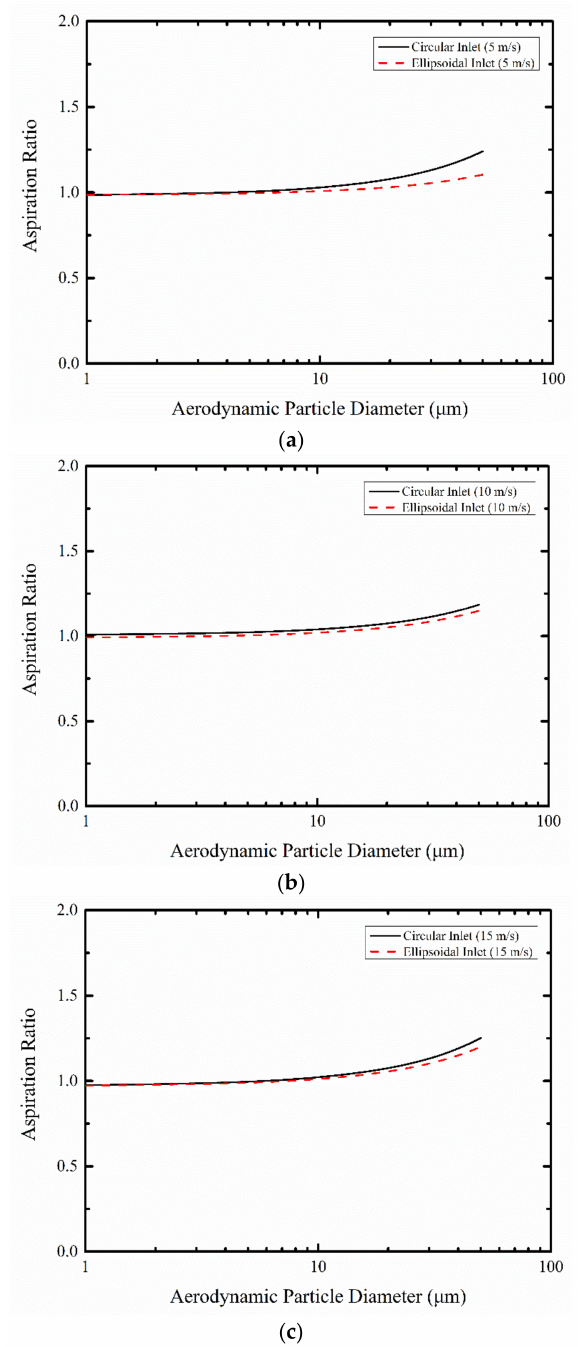
Figure 9. Comparison of aspiration ratio according to inlet type of the sampling probe: ( a ) 5 m/s, ( b ) 10 m/s, and ( c ) 15